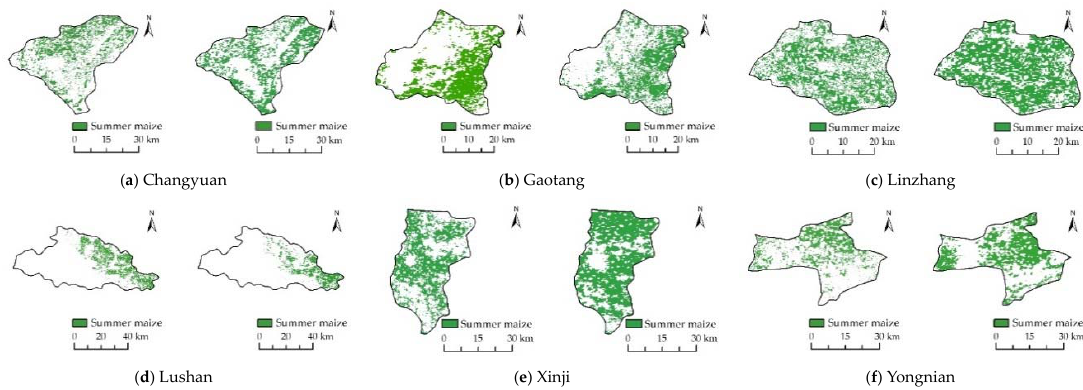
Figure 12. Comparison of spatial distribution of summer maize extraction results based on MODIS and Landsat images in 2012 (Left: MODIS, Right: Landsat). Table 6. Comparison of summer maize extraction results based on MODIS and Landsat images in 2012.